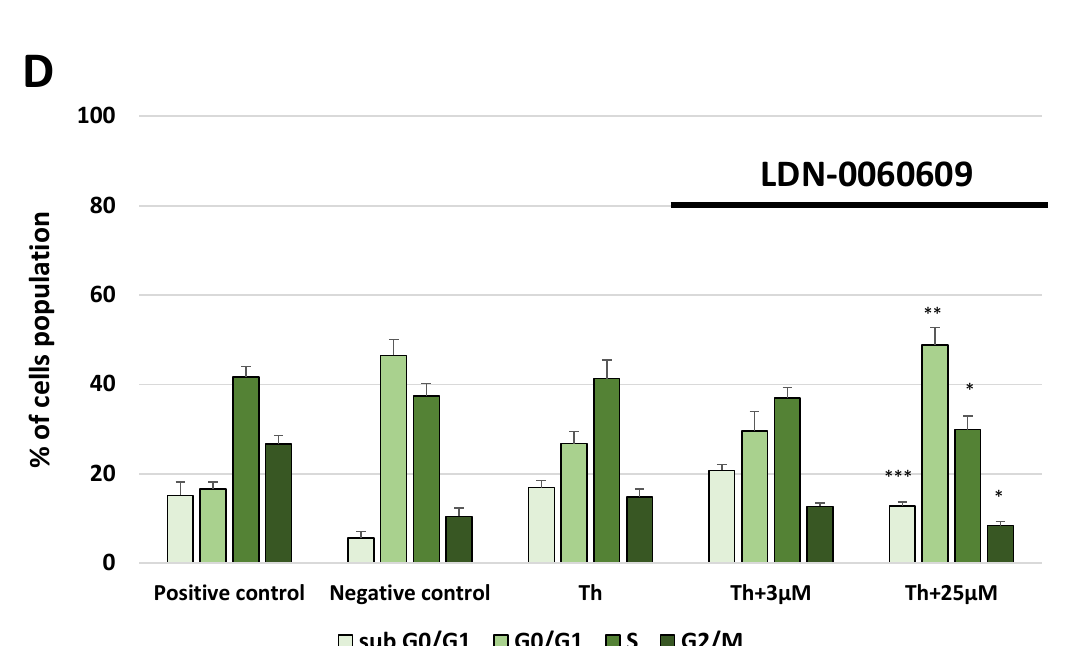
Figure 10. Analysis of cell cycle progression of HTM cells treated with the PERK inhibitor LDN-0060609 only ( A , B ) and after treatment of HTM cells with the Th and PERK inhibitor LDN-0060609 ( C , D ) by flow cytometric propidium iodide (PI) staining. DNA content histograms ( A , C ) and cell cycle distribution bar graph determined from DNA content histograms ( B , D ). Each of the statistical analysis in individual experiments was based on the results of three independent tests. Data are expressed as mean ± SE ( n = 3). On the graphs, the differences were statistically significant as follows: * p < 0.05, ** p < 0.01, *** p < 0.001 versus the negative control ( B ) and versus Th ( D ). DMSO—dimethyl sulfoxide;